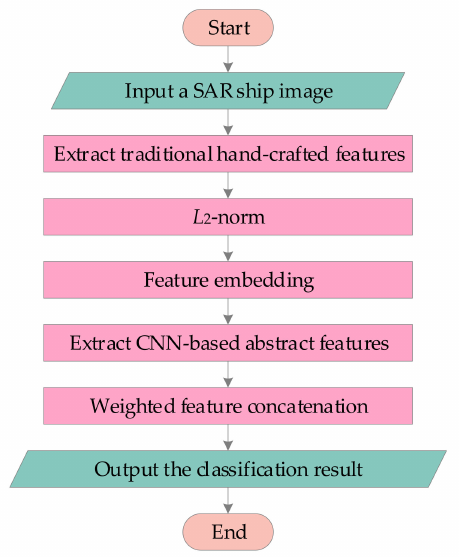
Figure 19. Execution flow chart of the proposed injection technique with